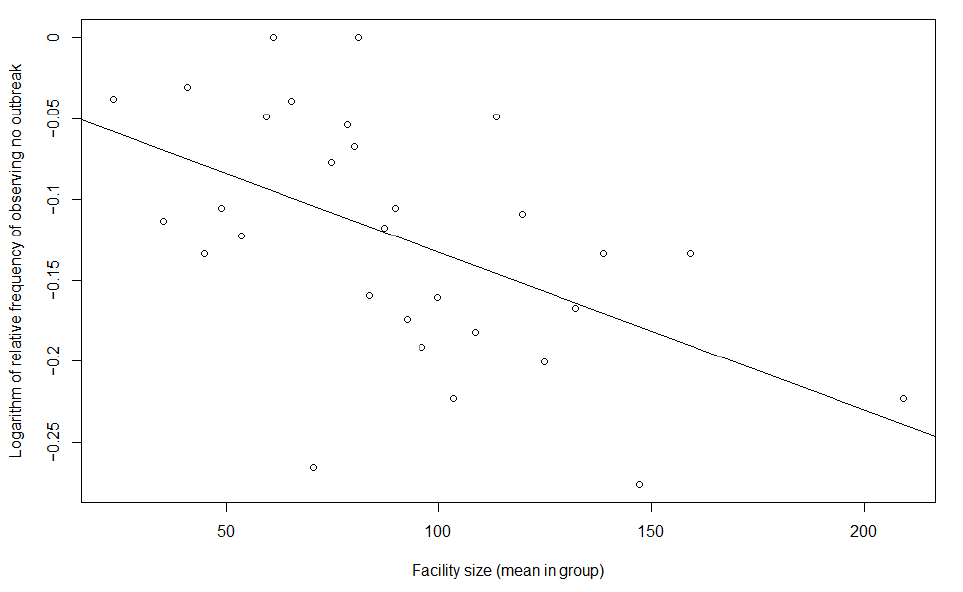
Figure A1. Plotting the logarithmic frequency of observing no outbreak against the facility size in the first wave.